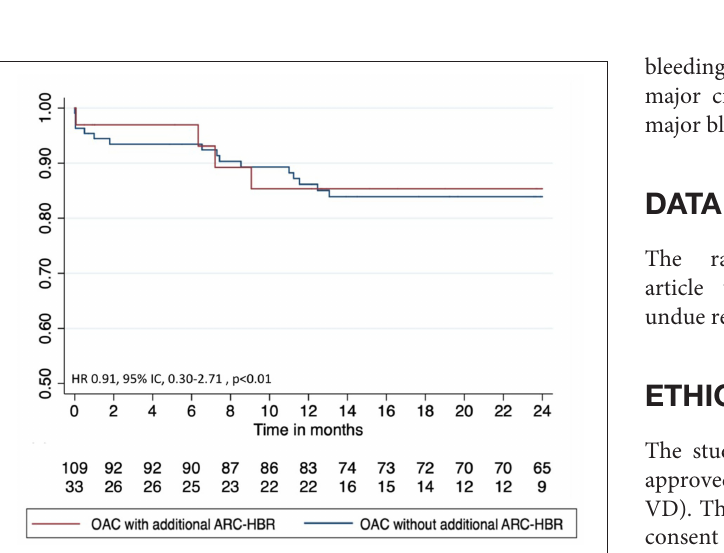
FIGURE 4 | Twenty-four months survival free from the patient-oriented-composite endpoint. ARC, Academic Research Consortium High Bleeding Risk; HBR, high bleeding risk; OAC, oral